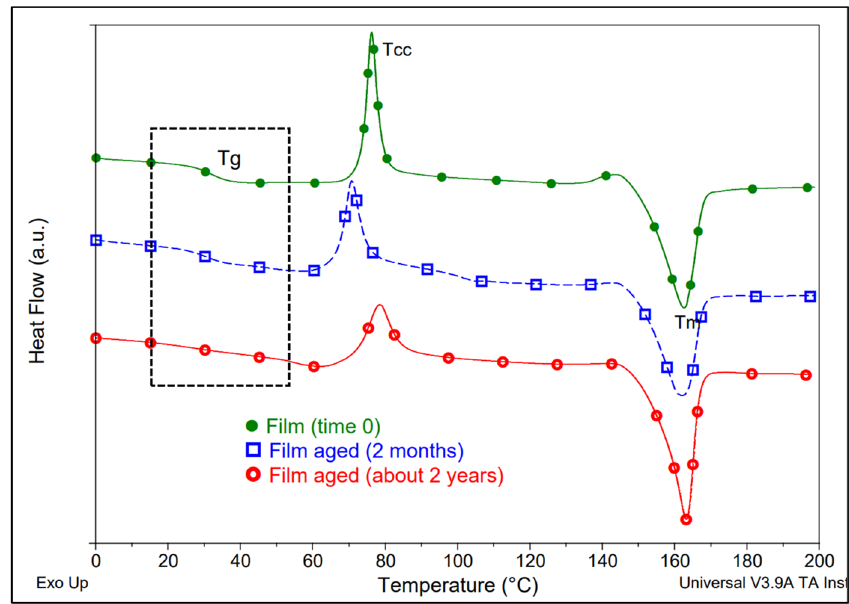
Figure 16. DSC curves (first scan, 10 °C/min) of plasticized composites (PLA/0.3J–AII–10TBC) as films, before and after the aging up to 2 years.